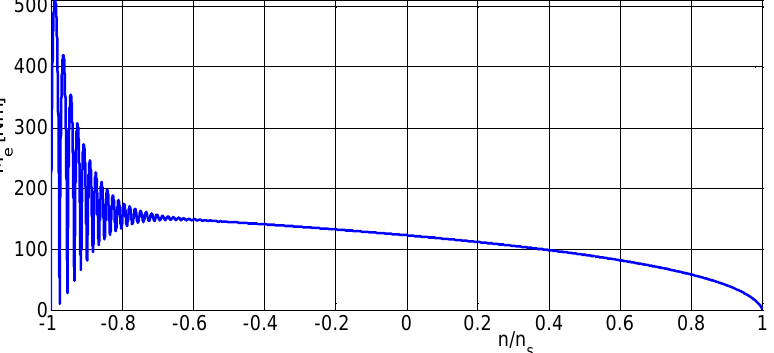
Figure 11. Torque – speed M e ( n ) trajectory of a solid-rotor induction motor during the reversion. In Figure 12, a flowchart of the calculation process is presented.